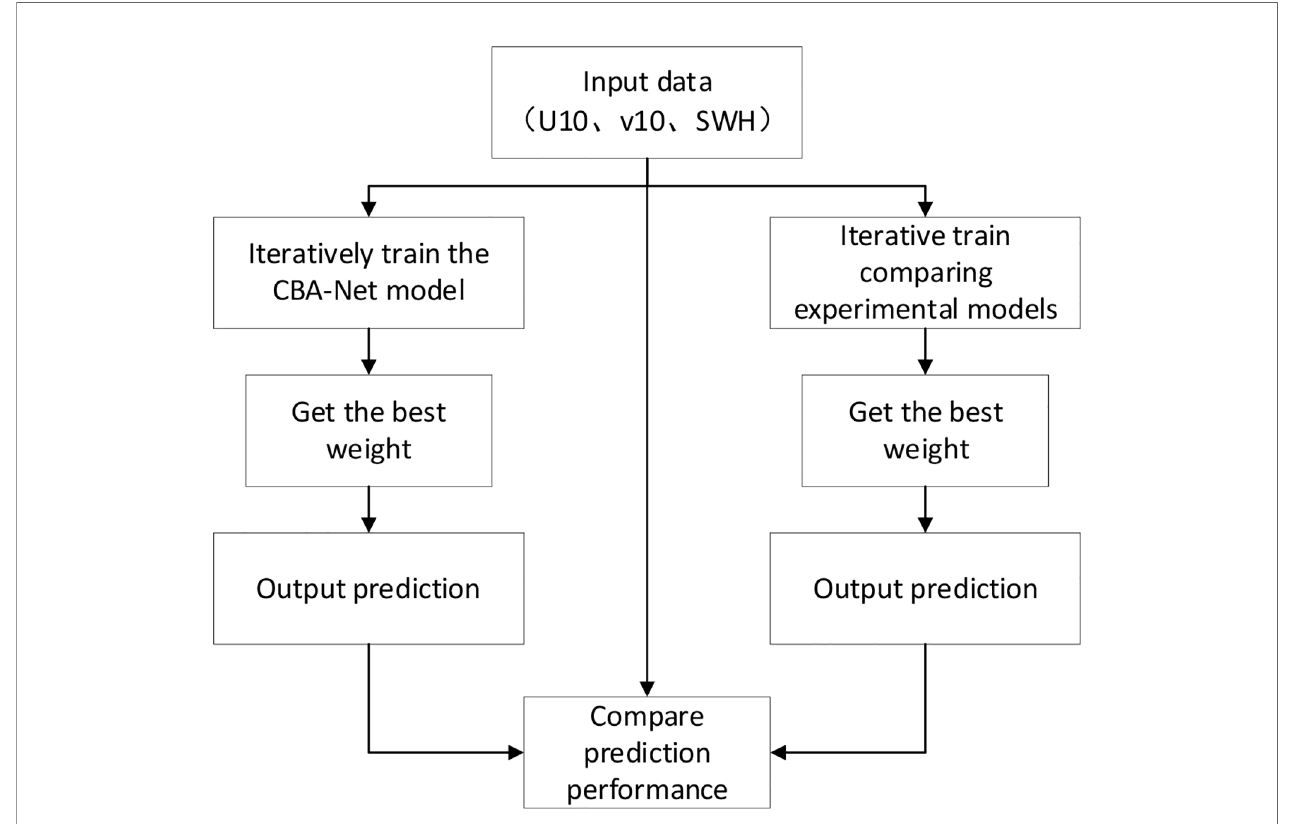
FIGURE 5 | Experiment